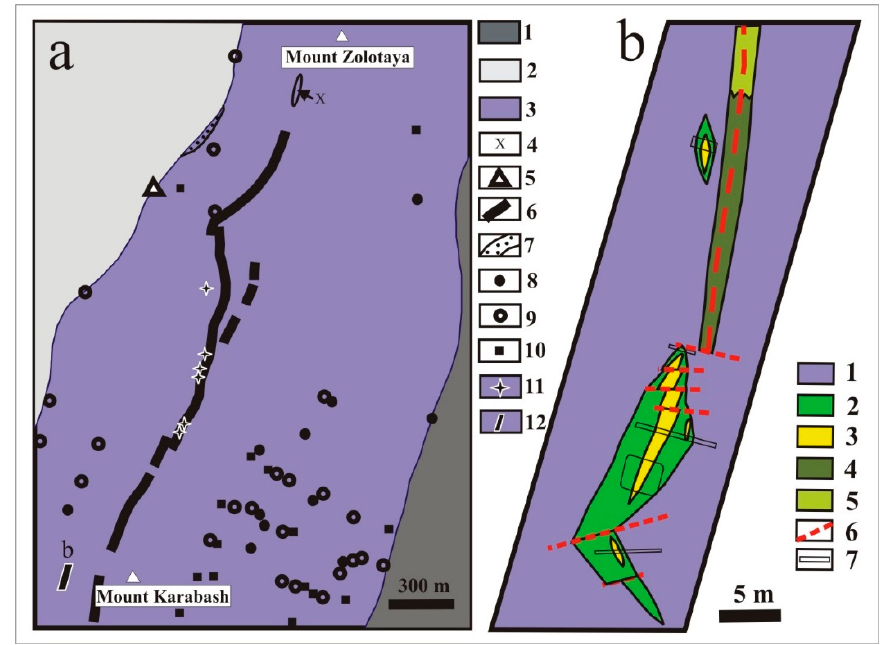
Figure 2. Geological position and types of hydrothermal-metasomatic rocks in the Karabash massif: ( a ) Spatial location of metasomatized rocks in the central part of the Karabash massif based on the geological map on a scale of 1:10,000 compiled by Lozhechkin [10] from the results of geological studies in 1933–1935. 1, Ordovician rocks of the Polyakovka Formation; 2, Devonian rocks of the Karamalytash and Ulutau Formations; 3, serpentinites; 4, diorite-porphyrites; 5, quartz diorite-porphyrites; 6–10, altered rocks: 6, rodingites: 7, listvenites; 8, epidote-chlorite-garnet; 9, magnetite-chlorite-carbonate; and 10, quartz-riebeckite; 11, mine workings (mines and adits) at the Zolotaya Gora deposit; and 12, location of the studied area. ( b ) Occurrence of lenses of magnetite-chlorite-carbonate rocks in the zone of foliated serpentinites in the west of the Karabash massif. 1, antigorite serpentinite; 2, chloritolite; 3, lenses of magnetite-chlorite-carbonate rocks; 4, intensely carbonatized serpentinite; 5, serpentinite with dispersed carbonate mineralization; 6, faults; 7, mine workings. Figure 2 is the reproduction of Figures 2 and 3 published in Murzin et al. [8].